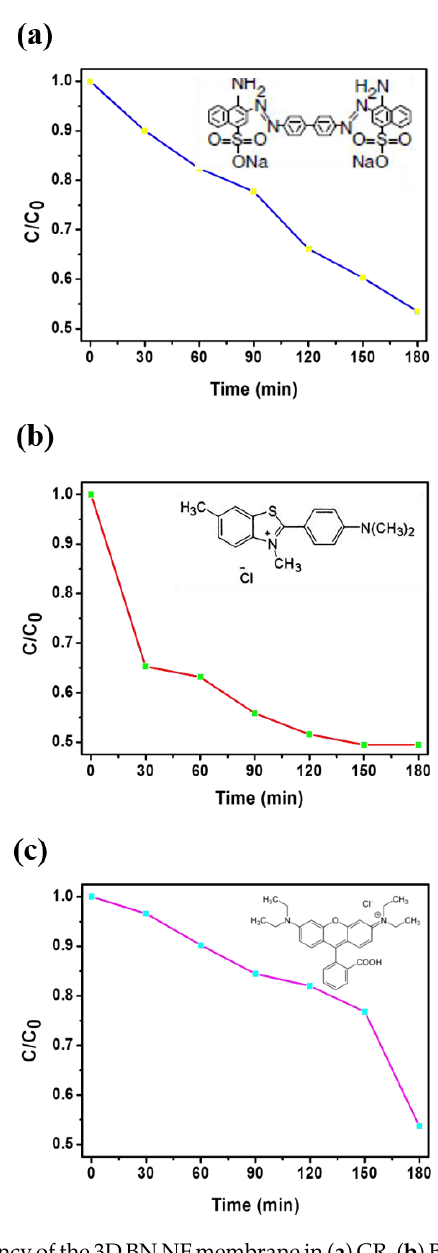
Figure 9. The removal e ffi ciency of the 3D BN NF membrane in ( a ) CR, ( b ) BY, ( c ) Rh B aqueous solutions.